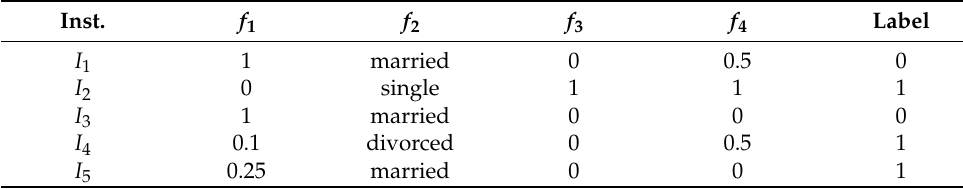
Table 4. Normalised data.